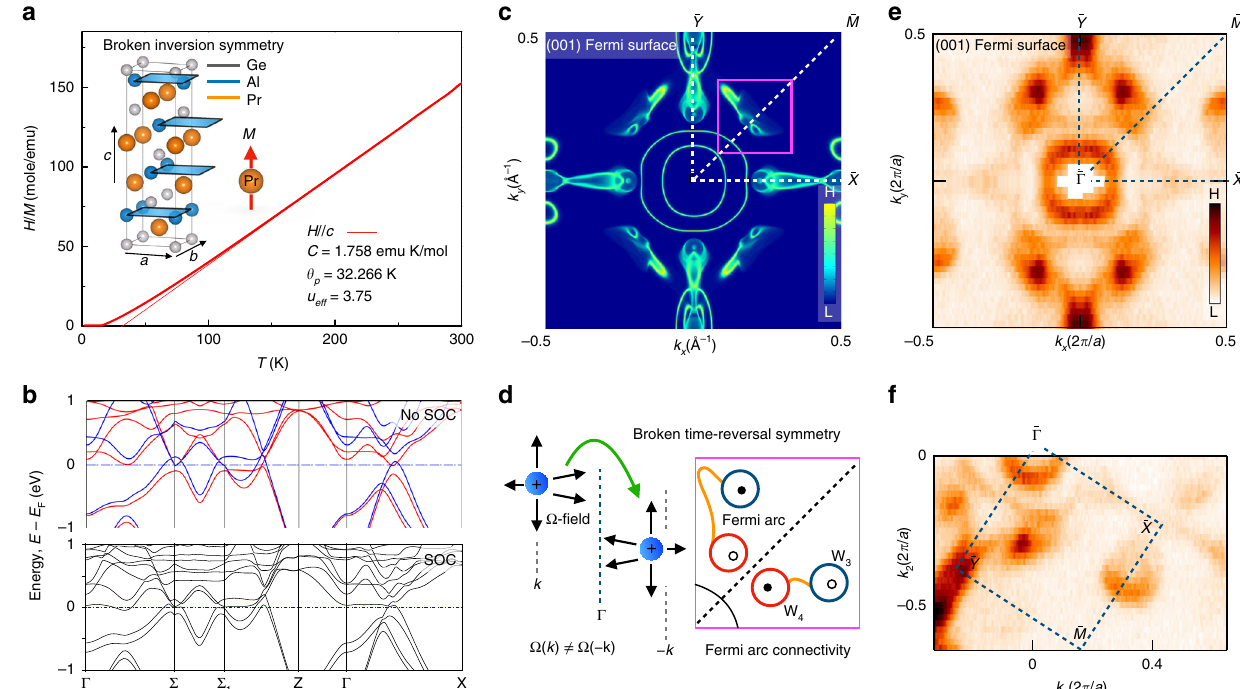
Fig. 1 Lattice and electronic structure of non-centrosymmetric spin-orbit magnet PrAlGe. a Inverse magnetic susceptibility as a function of temperature (thick line) with fi t to a Curie-Weiss law (thin line). Curie temperature T C = 16 K was measured. Inset: crystal structure of PrAlGe in space group I 4 1 md (No. 109). The square stacking pattern results in broken inversion symmetry. b Ab initio calculated bulk band structure of PrAlGe without (top panel) and with (bottom panel) spin-orbit coupling. The spin-up and spin-down states are shown in red and blue, respectively. c Ab initio calculated Fermi surface for the (001) surface. White dashed box: fi rst quadrant of the surface BZ. d Left panel: breaking time-reversal symmetry allows the Weyl fermions ( + ), represented as sources of Berry curvature Ω fi elds, to be shifted in the crystal momentum space so they are no longer appear pairwise at ± k . Right panel: Fermi arc connectivity (orange lines) schematic for the projected Weyl fermions (black and white circles), corresponding to the magenta box in c . A pair of projected W 3 and W 4 Weyl fermions on each side of the Γ (cid:1) M line. The predicted con fi guration of projected Weyl fermions manifestly breaks time- reversal symmetry. e Symmetrized and f un-symmetrized Fermi surface obtained by low-energy